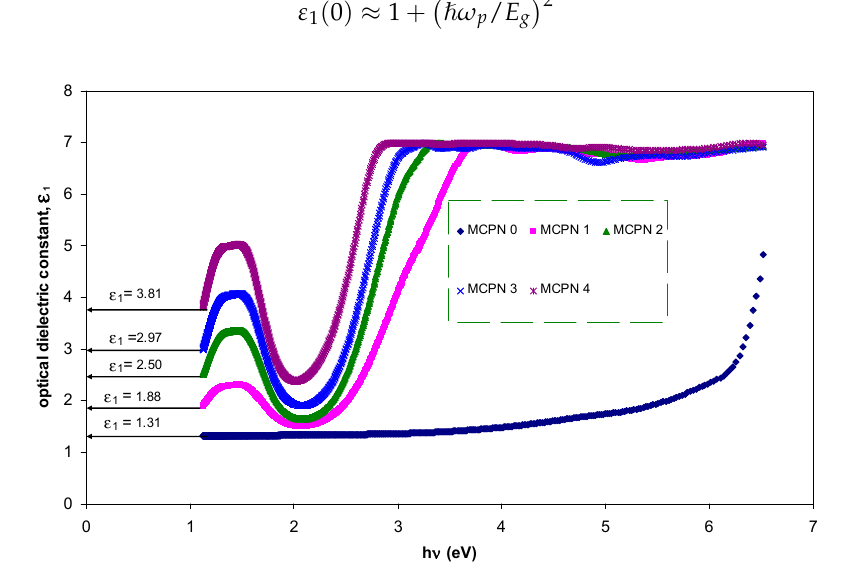
Figure 8. Optical dielectric constant versus photon energy for pure MC and doped MC samples.